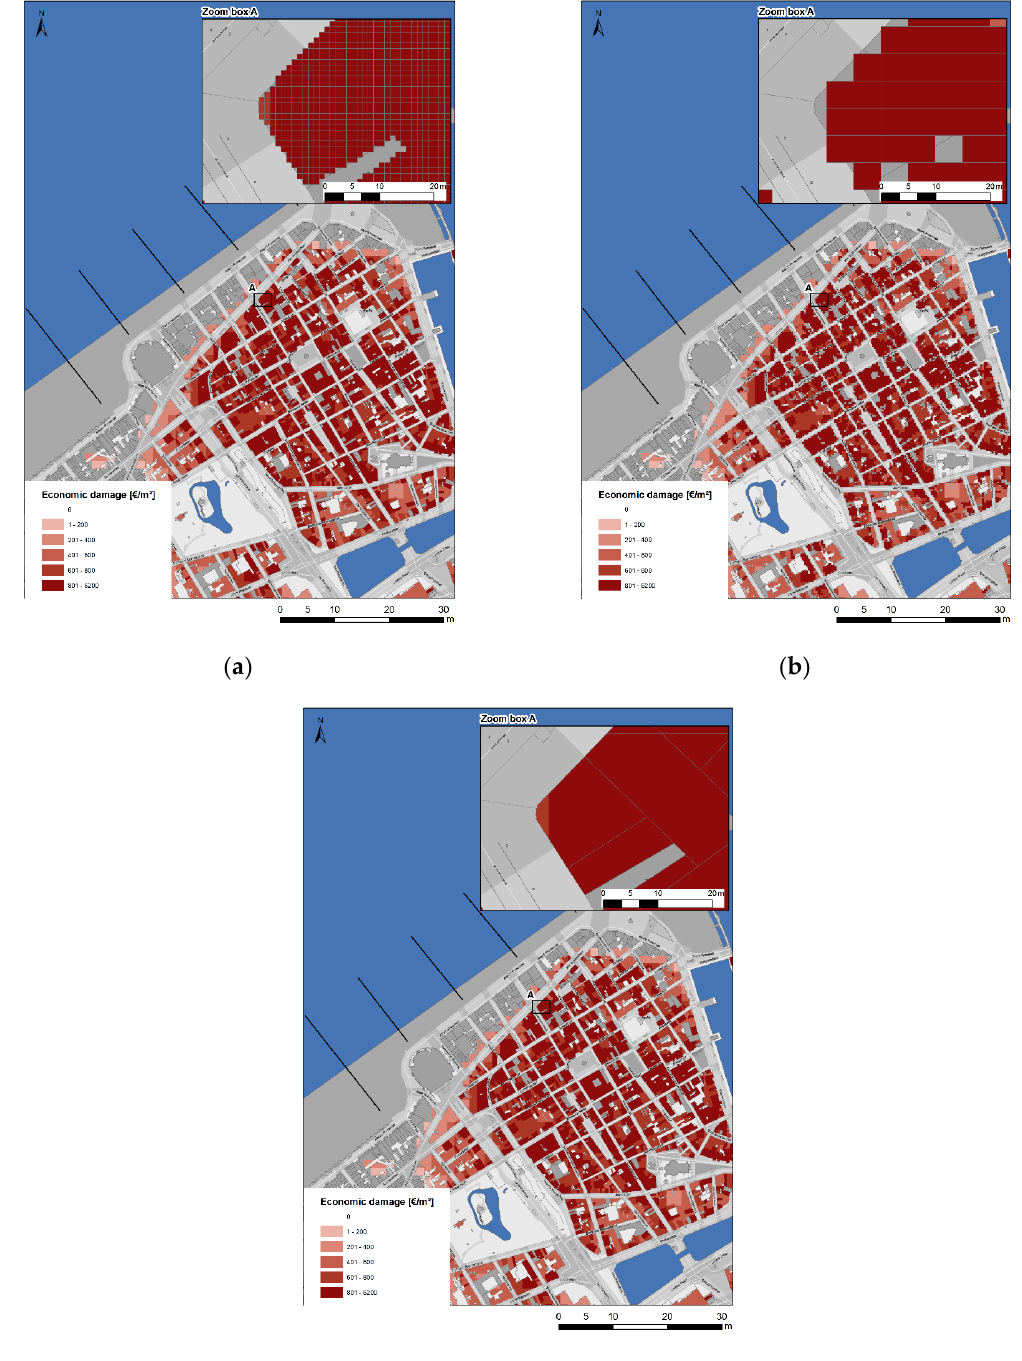
Figure 18. Economic damage calculation with LATIS with 1 m resolution ( a ), 5 m resolution ( b ), and FLIAT ( c ).